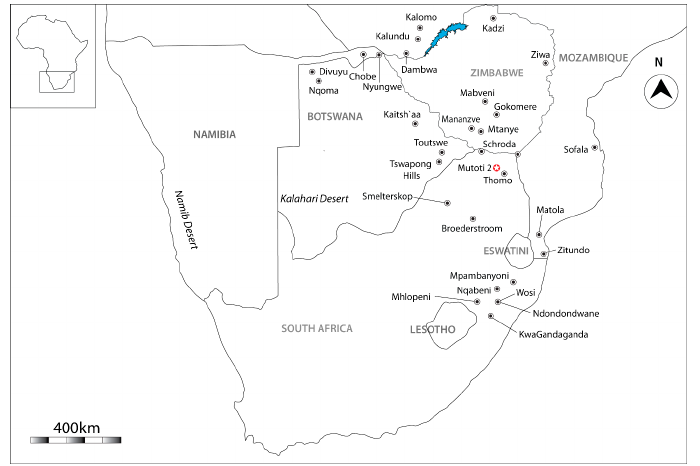
Figure 1. Location of Mutoti 2 in relation to other Early Iron Age sites recorded in Southern Africa. 2. Background to Mutoti 2 The now submerged EIA site of Mutoti 2 (22°58 ′ 53.75 ′′ S 30°35 ′ 50.47 ′′ E) was originally situated on the summit of a small hill formed on the banks of the Luvhuvhu River south of the Soutpansberg, and 15 km southeast of Thohoyandou in the village of ha-Mutoti (Figure 1). As part of the pre-development heritage impact assessment and mitigation in advance of the construction of Nan ḓ oni (meaning the place of the furnace) Dam in 2002, the site was excavated before being inundated with water. Edwin Hanisch initially exca- vated the site in 1997 as part of a Cultural Resource Management Programme commis- sioned by the Department of Water Affairs and Forestry (DWAF) to salvage the archaeo- logical materials of the archaeological site for curation and future research at the Univer- sity of Venda [39]. Then, in 1998, Archaeo-Info Northern Province took over the work [40]. Geologically, the area in and around Mutoti 2 is dominated by the Soutpansberg groups (volcanic rocks) and the Drakensberg basalt of the Lebombo Mountains [41–43]. Generally, rich sections with varied minerals have been recorded throughout the area of Venda where Mutoti 2 is situated, for instance, iron ore (magnetite [Fe 3 O 4 ] and hematite [Fe 2 O 3 ]) sources were recorded at Vuu, Tshivhulana, and Thomo [31]. Some old iron ore mines characterised by open pits and trenches were recorded near Vuu village. These were exploited by the renowned iron smelters at Tshimpufe [12,28,32,44]. Judging by the quantities of production remains from iron smelting at Mutoti 2, iron ores played a signif- icant role in the economy of the EIA communities. The diverse vegetation of the area dom- inated by the Lowveld Bushveld (Figure 2) also offered multiple opportunities—for ex- ample, by providing wood for construction—for meeting energy requirements in domes- tic and craft-related activities.